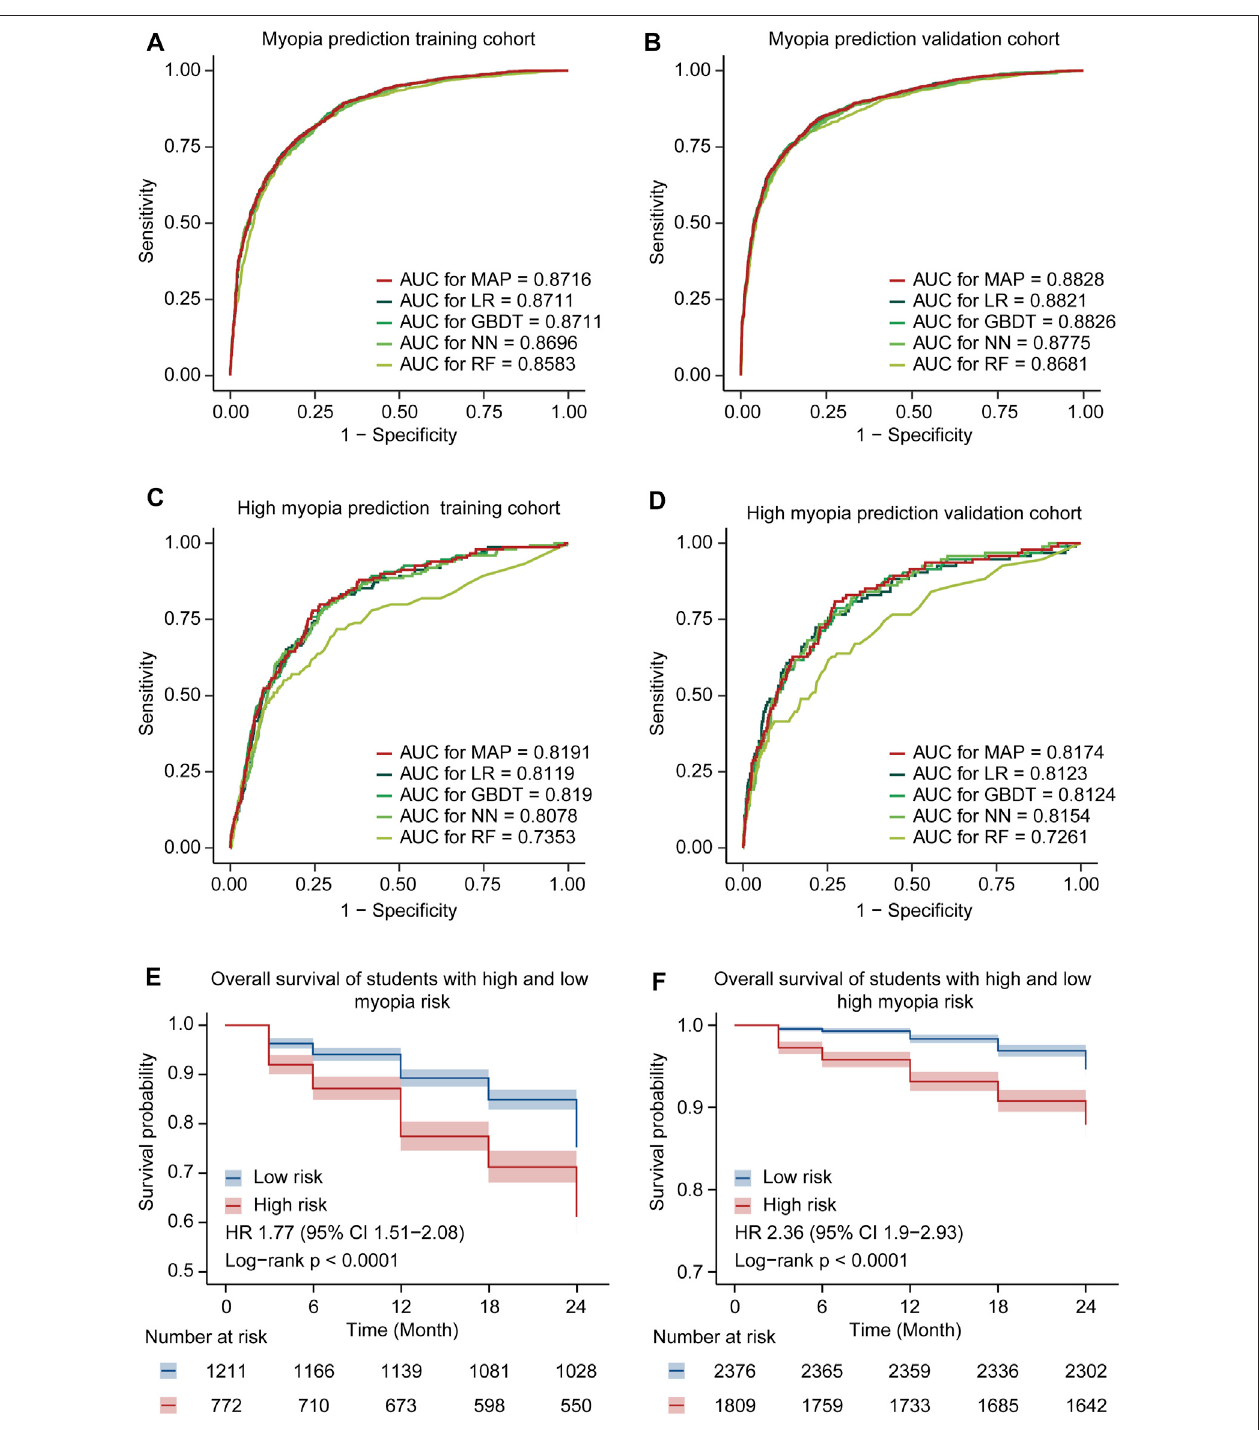
FIGURE 3 | Model performance comparison. (A) Comparison of ROC curves for the MAP model and the other ML models of myopia prediction in the training cohort. (B) Comparison ofROCcurvesfor theMAPmodeland theother MLmodels ofmyopia prediction inthevalidationcohort. (C) Comparison ofROCcurves forthe MAPmodelandtheotherMLmodelsofhighmyopiapredictioninthetrainingcohort. (D) ComparisonofROCcurvesfortheMAPmodelandtheotherMLmodelsofhigh myopiapredictioninthevalidationcohort. (E) TheKaplan – Meiercurvesfordevelopingmyopiaamongstudentsindifferentriskgroups.Shadedareasindicate95% con fi dence intervals. (F) The Kaplan – Meier curves for developing high myopia among students in different risk groups.